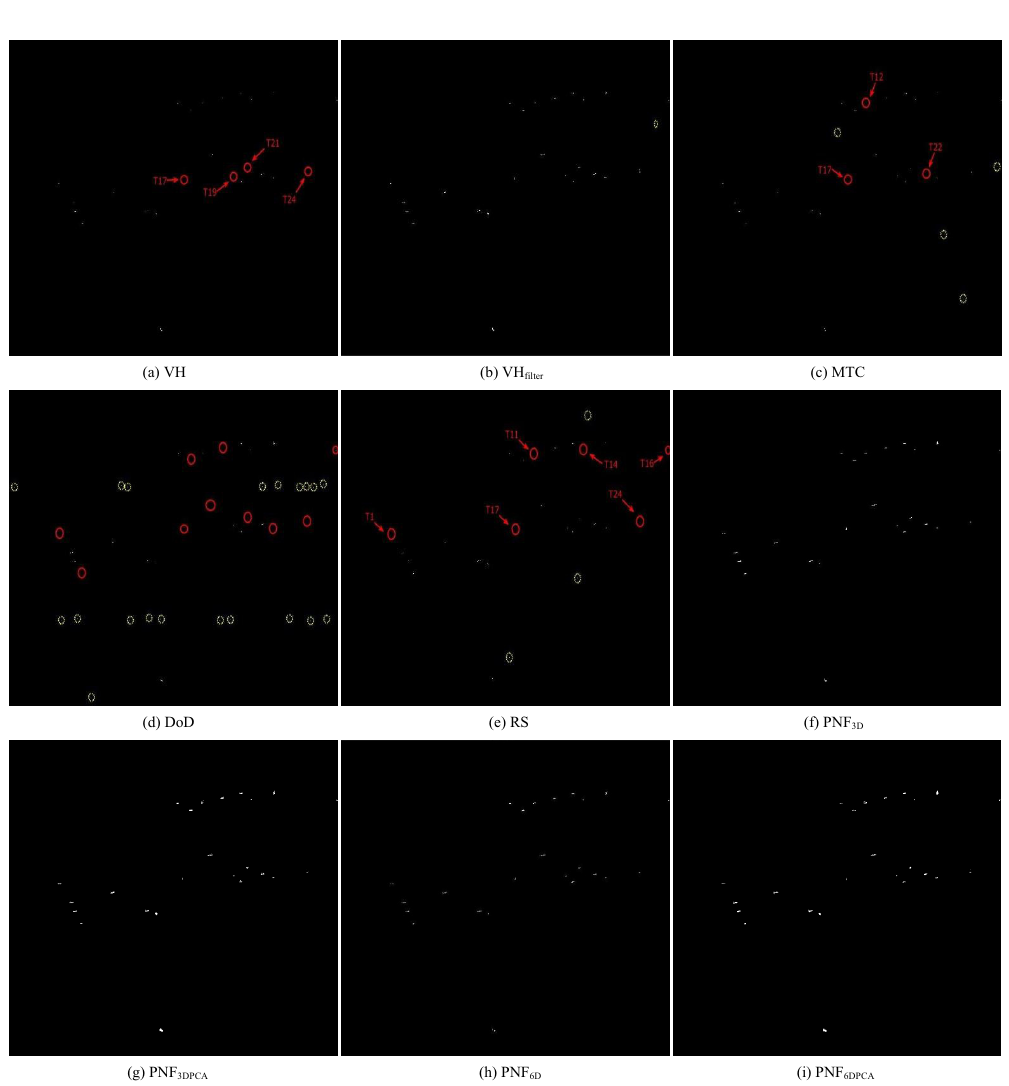
Figure 10. Ship detection results of different methods on C. ( a ) VH; ( b ) VH filter ; ( c ) MTC; ( d ) DoD; ( e ) RS; ( f ) PNF 3D ; ( g ) PNF 3DPCA ; ( h ) PNF 6D ; ( i ) PNF 6DPCA . Red circles indicate missing ships. Yellow dashed circles mean false